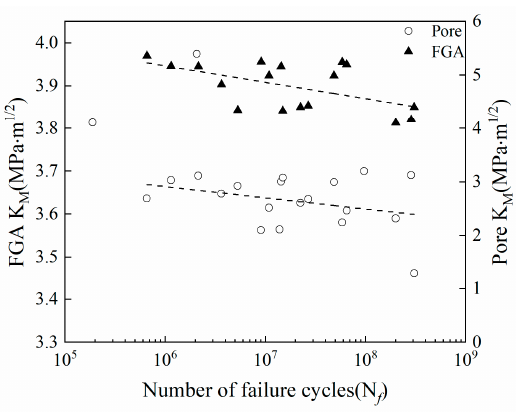
Figure 10. Relationship between K M of pores and fine granular area (FGA) and fatigue life.